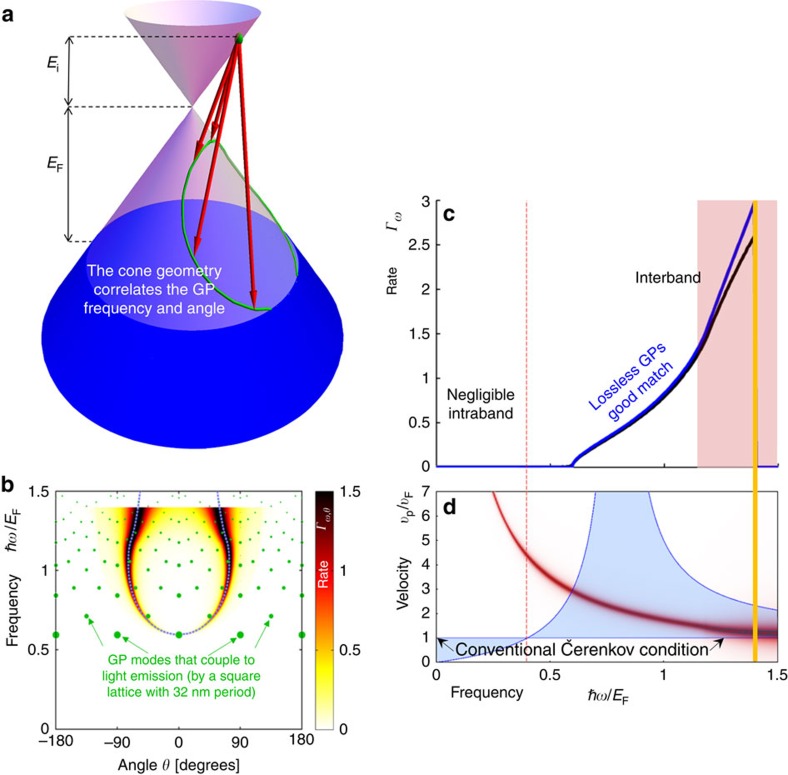
GP emission from hot carriers.Caption and notations same as in Fig. 2. The green dots in b show the GPs can be coupled out, as light, with each dot's size illustrating the strength of the coupling (in this case, the dots correspond to coupling out through a square lattice with a period of 32 nm in both dimensions). The hot carrier energy Ei=0.4EF. EF as in Fig. 2.